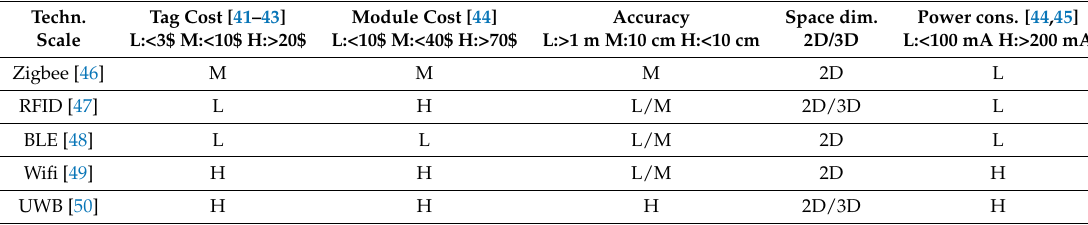
Table 2. Review of indoor positioning-based traceability technologies.